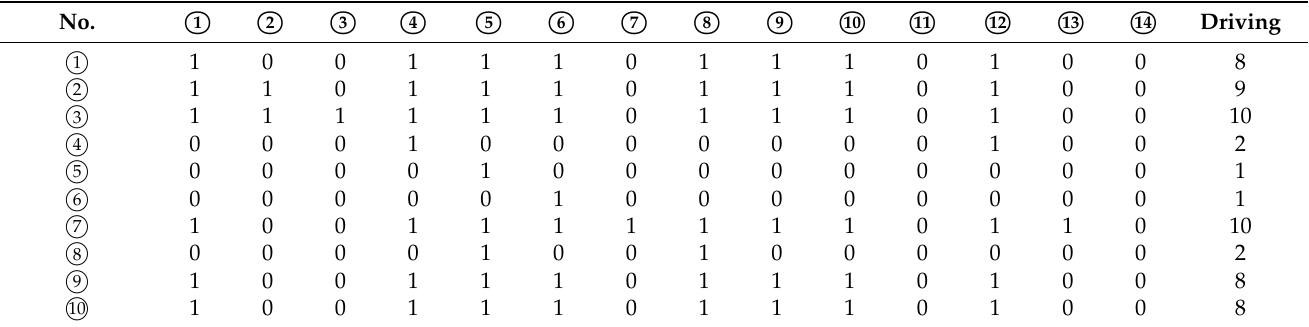
Table 5. The RM result of